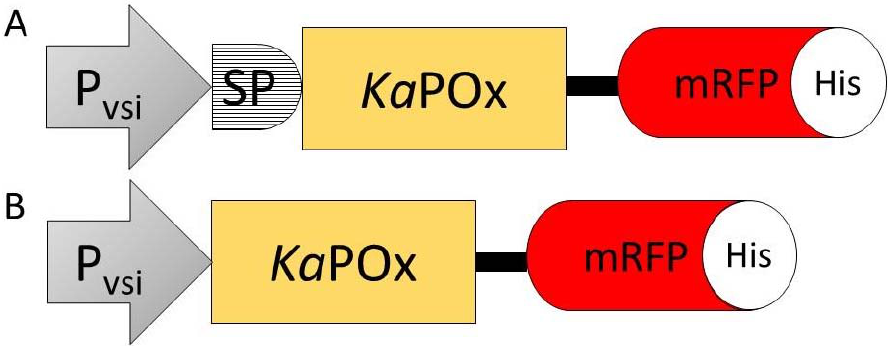
Figure 4. Constructs SP Ka POxmRFPHis ( A ) and Ka POxmRFPHis ( B ) containing the constitutive S. venezuelae P vsi promoter (P vsi ), the putative signal peptide (SP), the Ka POx mature domain, the mRFP fluorescent protein (mRFP) and a C-terminal 6×His-Tag (His).